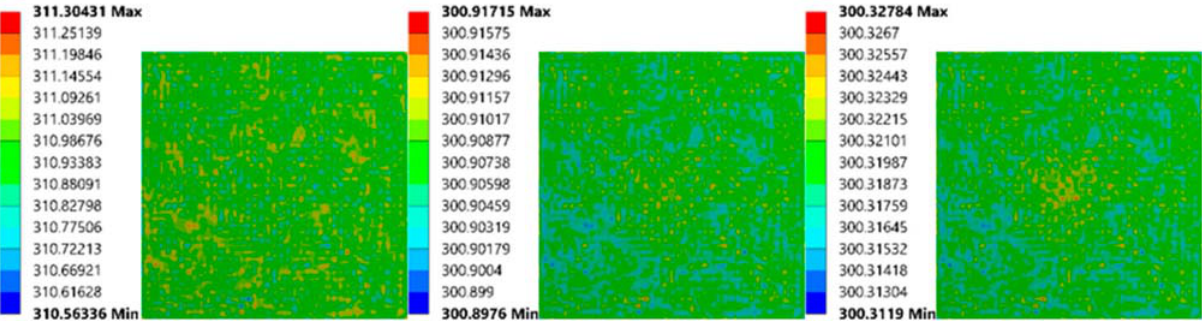
Figure 14. Simulation images of FEA model (1.98 mm diameter, 1.59 mm depth) at 30 s, 110 s, 150 s (from left to right).